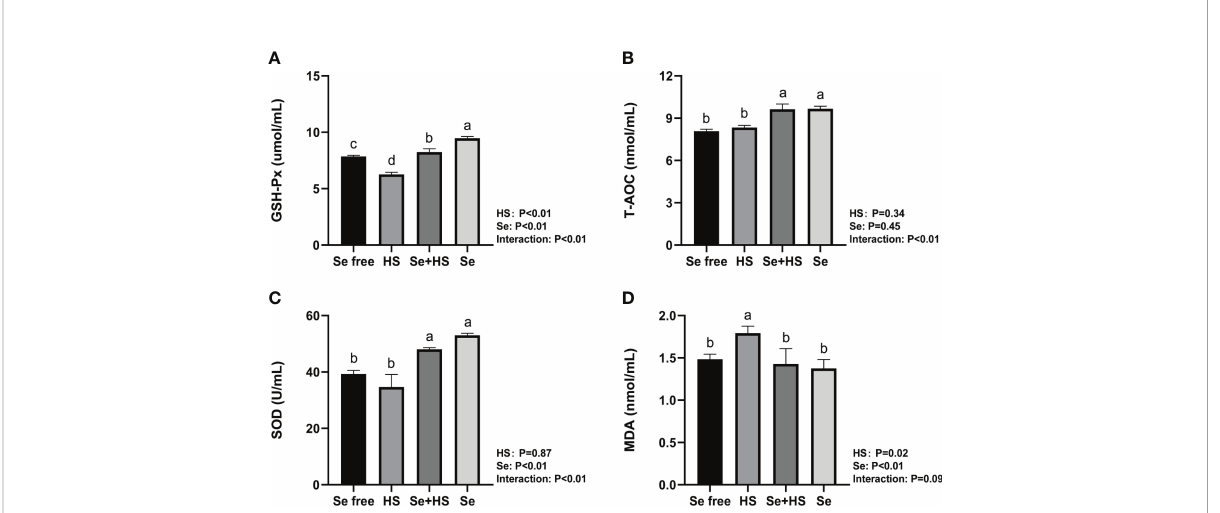
FIGURE 13 Effects of HMSeBA on the levels of antioxidant indexes in mammary gland of mice under HS (n = 12). The levels of glutathione peroxidase (GSH- Px) (A) , total antioxidant capacity (T-AOC) (B) , superoxide dismutase (SOD) (C) , and malondialdehyde (MDA) (D) were measured with an enzyme-linked immunosorbent assay. a-d Different lowercase letters indicate extremely signi fi cant differences between two groups ( P < 0.01), while the same lowercase letters indicate no signi fi cant difference between two groups ( P >